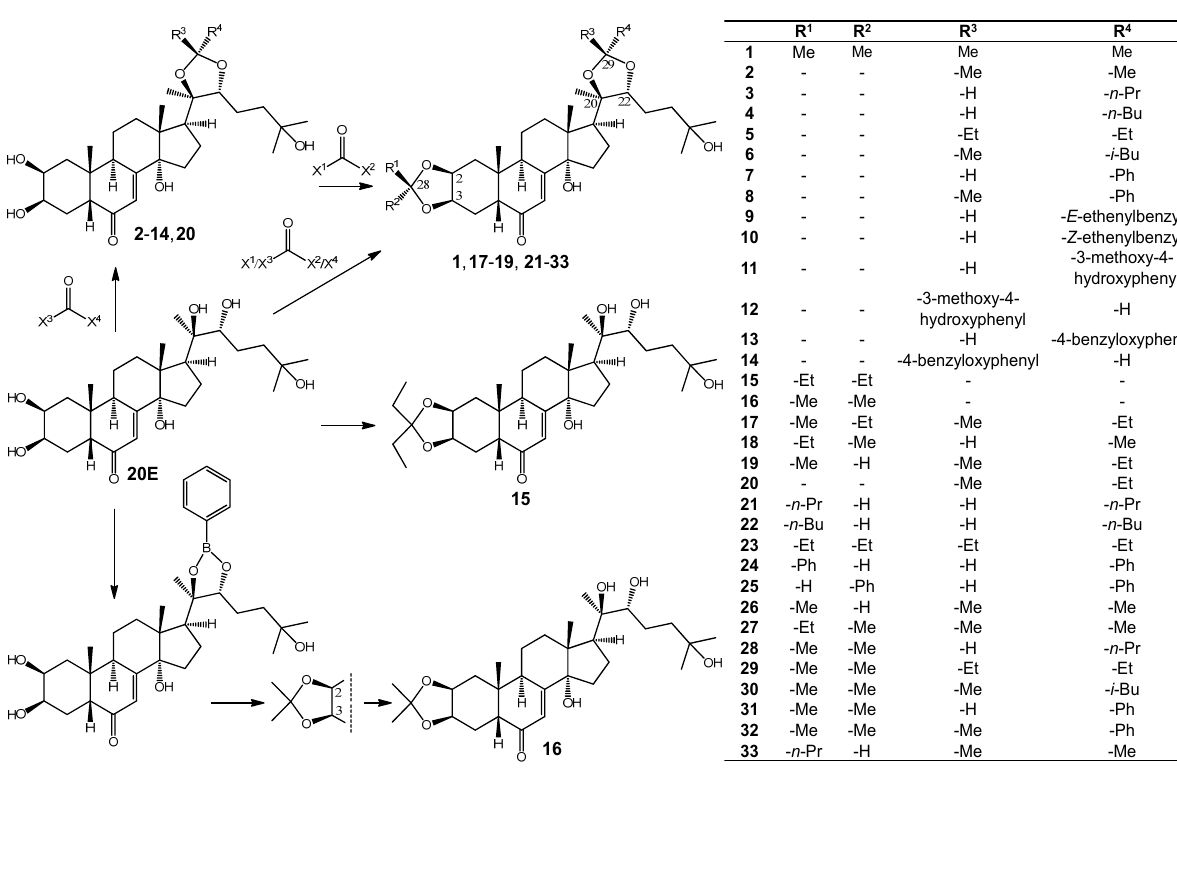
Figure 1. Semi-synthetic transformations of 20E and structures of the products obtained. Substituents of the reagent oxo-compound (X 1 /X 2 and X 3 /X 4 ) typically correspond to R 1 /R 2 and R 2 /R 3 , respectively, except for compounds 18 and 19 , where the reagent was methyl-ethyl ketone. 15 was obtained as a side product from the synthesis of 23